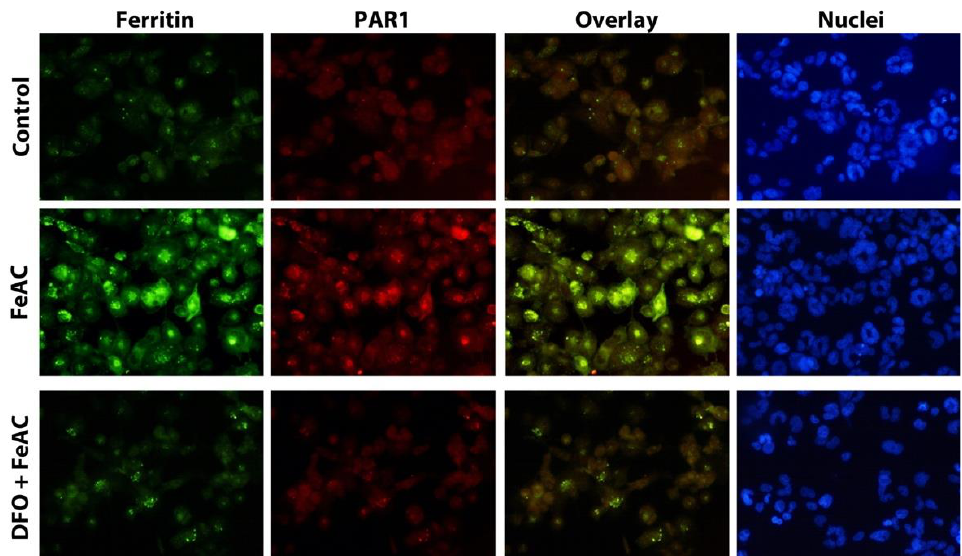
Figure 3. Iron exposure causes significant induction of cellular ferritin and PAR1 in THP-1 macrophages. THP-1 macrophages were either left untreated or were treated with FeAC (100 µg/mL) for 24 h or pretreated with iron chelator DFO (1 mM) for 1 h and then exposed to FeAC for 24 h without DFO. Following double immunocytochemistry for PAR1 and ferritin, the cells were examined by fluorescence microscopy. Representative photographs of PAR1 (red) and ferritin (green). Nuclei stained blue with DAPI.